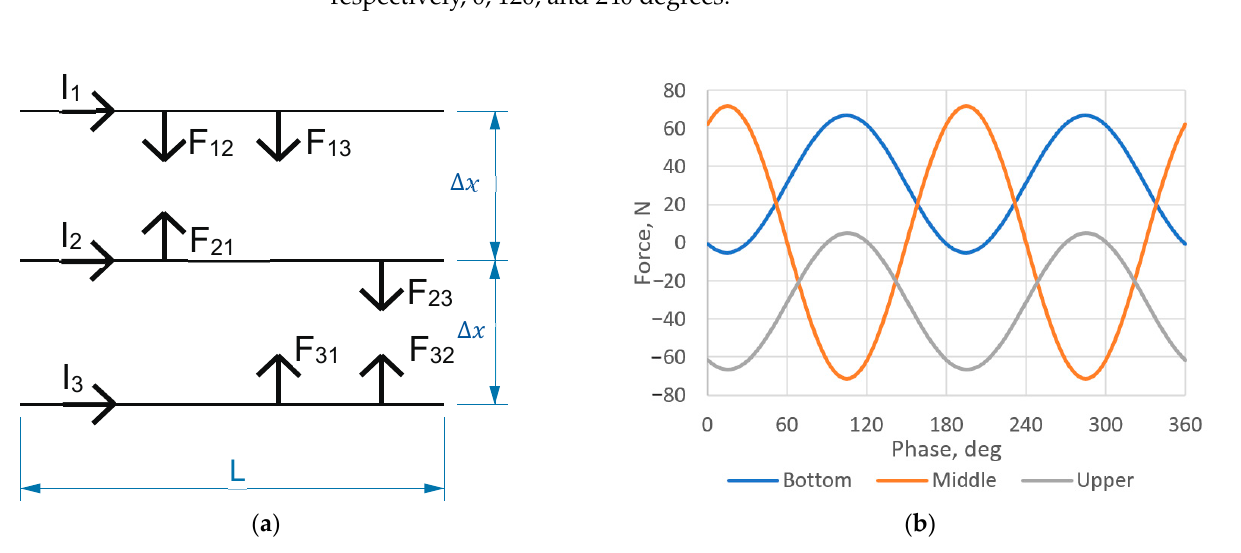
Figure 2. ( a ) Forces acting on 3 parallel conductors; ( b ) instantaneous forces acting on plane, 200 mm long system of three-phase conductors in air shifting each other by 60 mm and carrying 10 kA peak current.